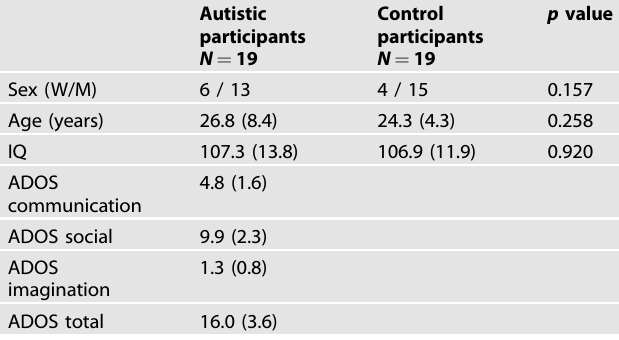
Table 1. Demographic and psychometric